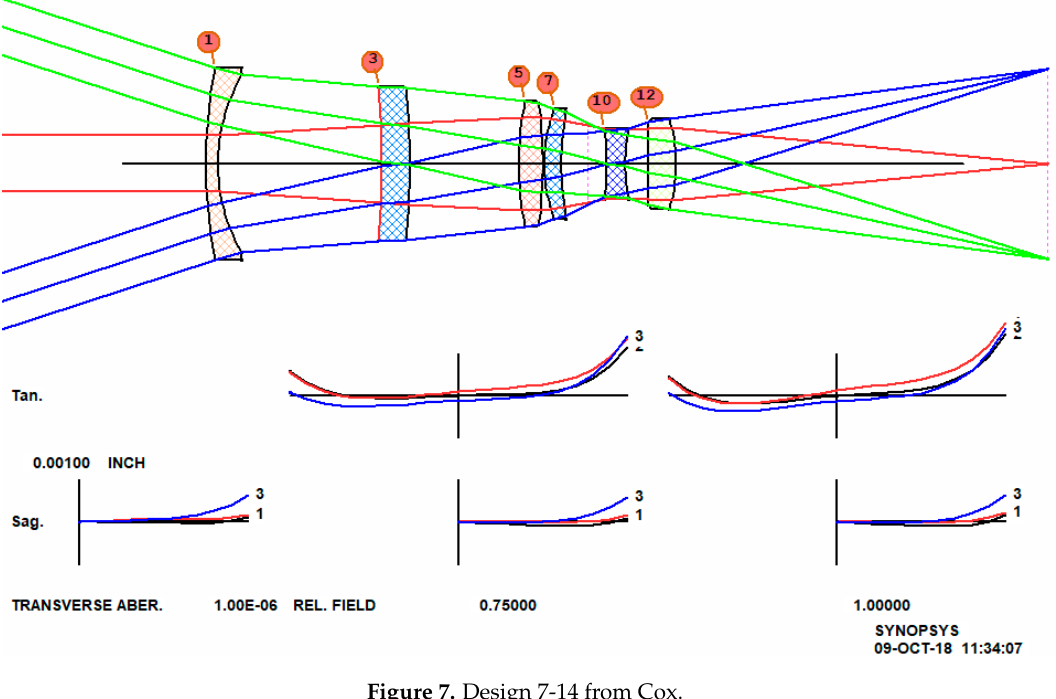
Figure 7. Design 7-14 from Cox.